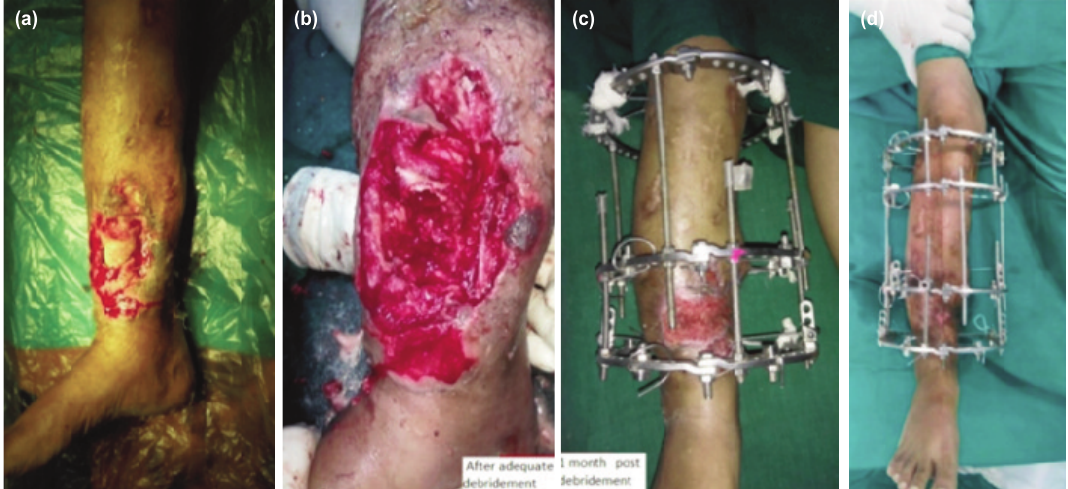
(a) A case of non-union following Type III B open fracture. (b) After debridement with a bone gap of 8cm. (c) One month post- Fig. 2: op picture after ASRL showing wound healing by secondary intention. (d) At follow-up for ring